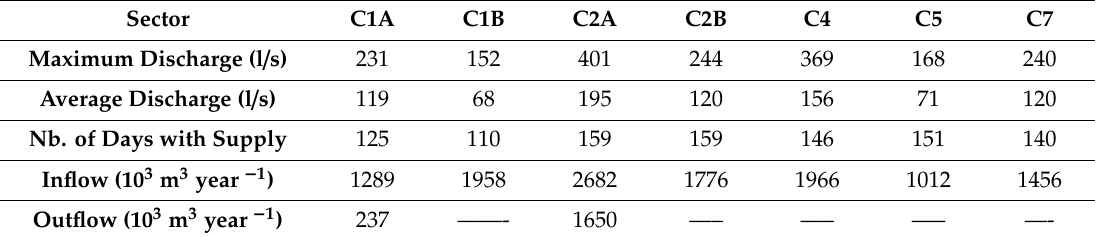
Table 3. Irrigation supply and outflow characteristics per Sector, in